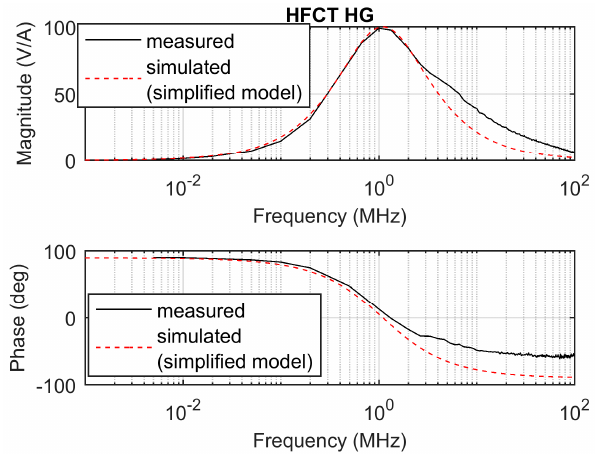
Figure 5. HFCT_HG sensor frequency response, measured and simulated, using the simplified model (one zero and two poles).